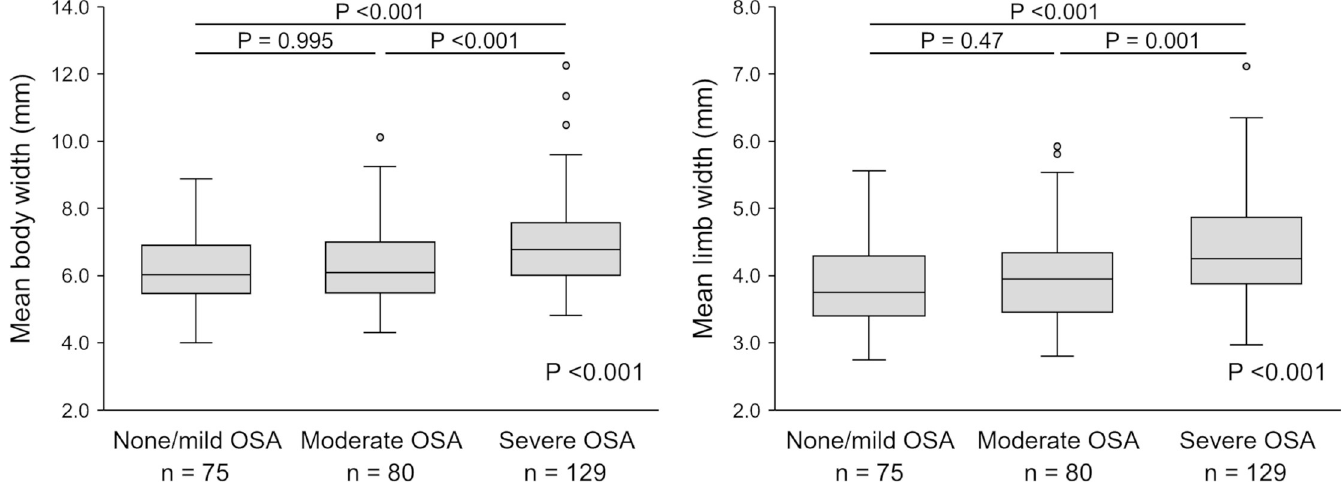
Fig 3. Mean body and limb width according to OSA severity. The box in box plots shows the IQR and the line within the box shows the median. The upper whisker shows the 75 th percentile plus 1.5 x IQR, and the lower whisker shows the 25 th percentile minus 1.5 x IQR. Dots indicate the outliers. Analyses were conducted by the Kruskal-Wallis test and Steel-Dwass test for post hoc pair wise